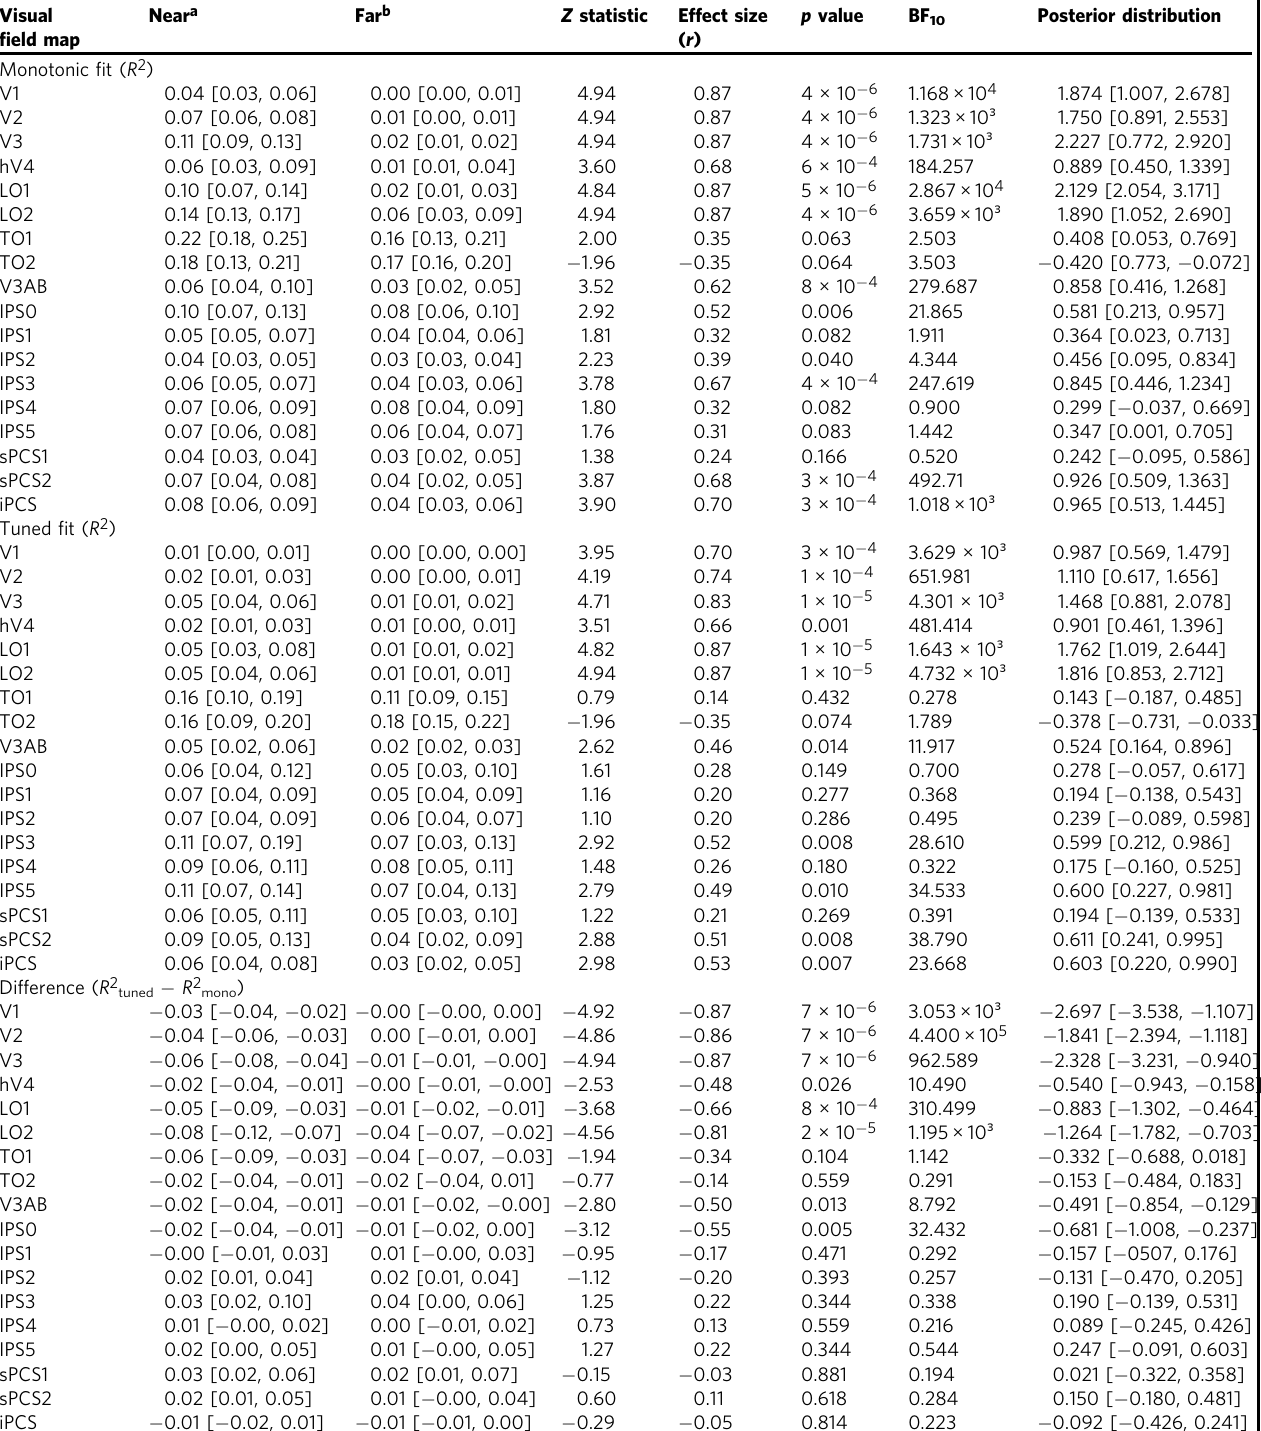
Table 2 Descriptive and test statistics of the paired eccentricity range comparisons within visual fi eld maps for the monotonic response model, tuned response model, and the difference between their fi